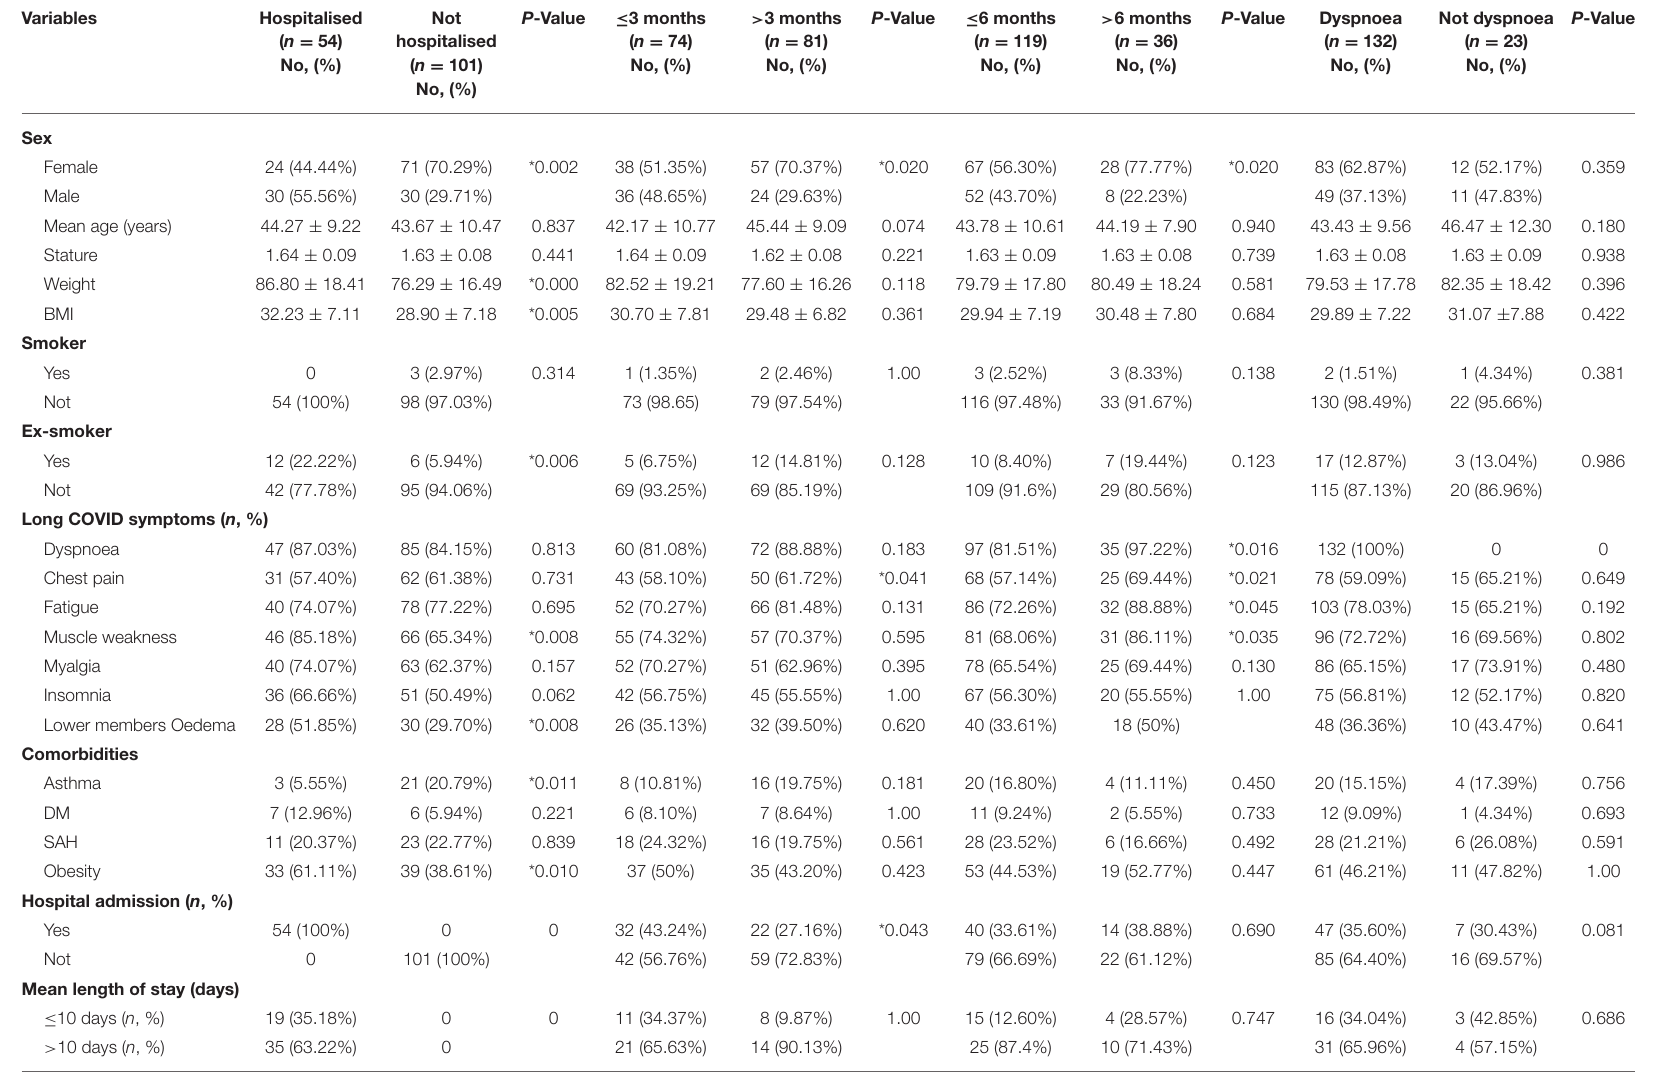
TABLE 2 | Demographic characteristics, comorbidities, and symptoms of the study population considering the long COVID clinical